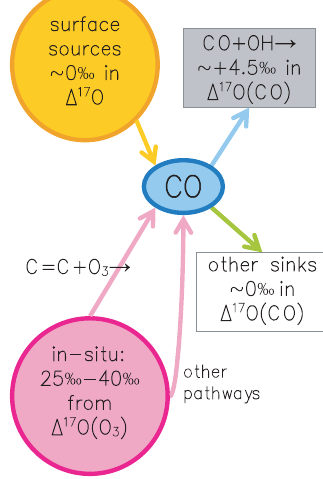
Fig. 4. Main sources and sinks determining the 1 17 O signal in carbon